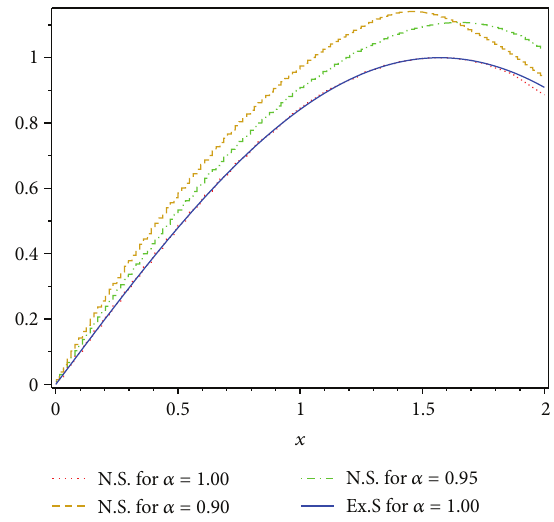
Figure 1: Numerical solution (N.S.) and exact solution (Ex.S).